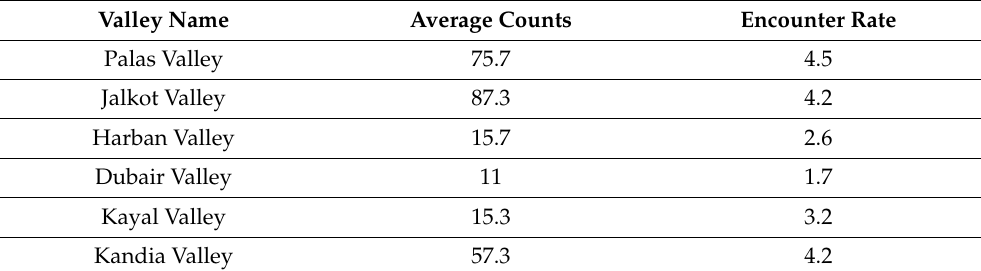
Table 1. An abundance of pheasants includes valley-wise abundance and their encounter rate.